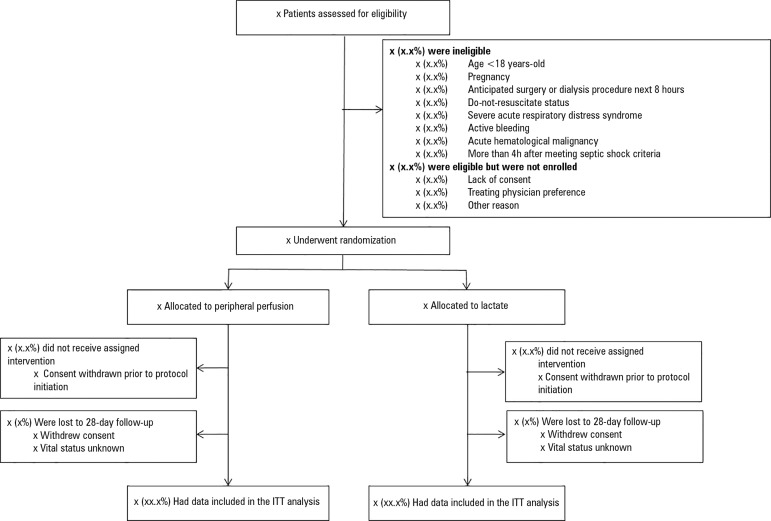
Flow of patients in the ANDROMEDA-SHOCK trial.ITT - intention-to-treat.